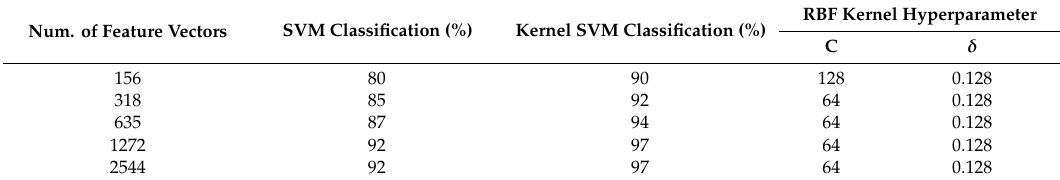
Table 6. Results of classification by SVM and kernel